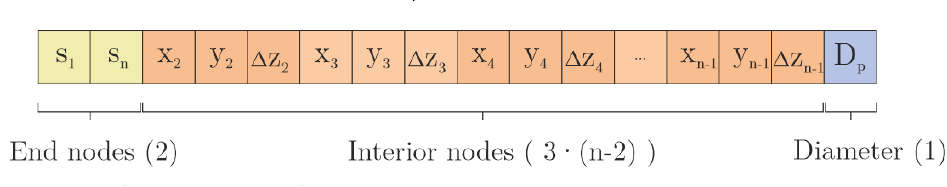
Figure 7. Chromosome